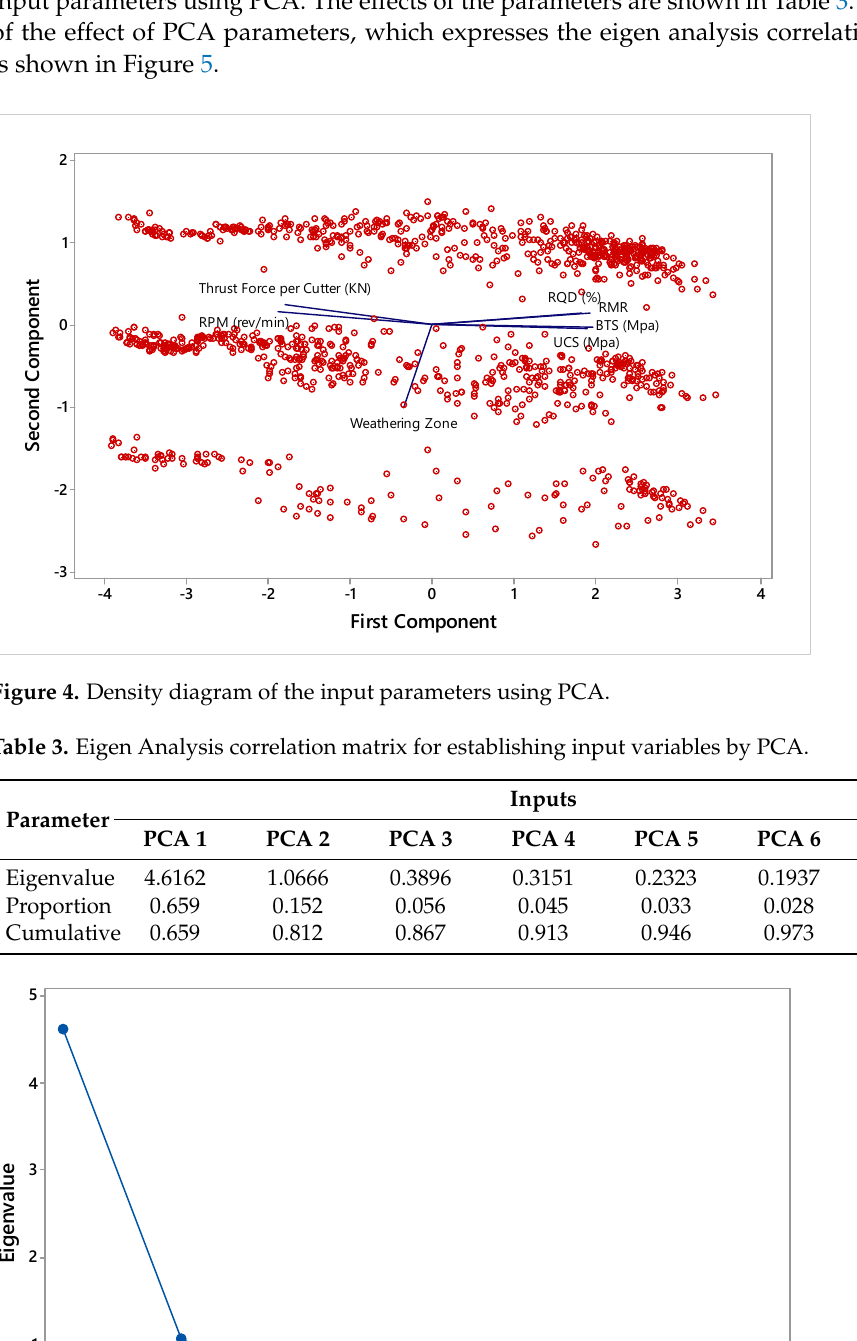
Figure 5. Eigen Analysis correlation matrix in displaying the PCA parameters.